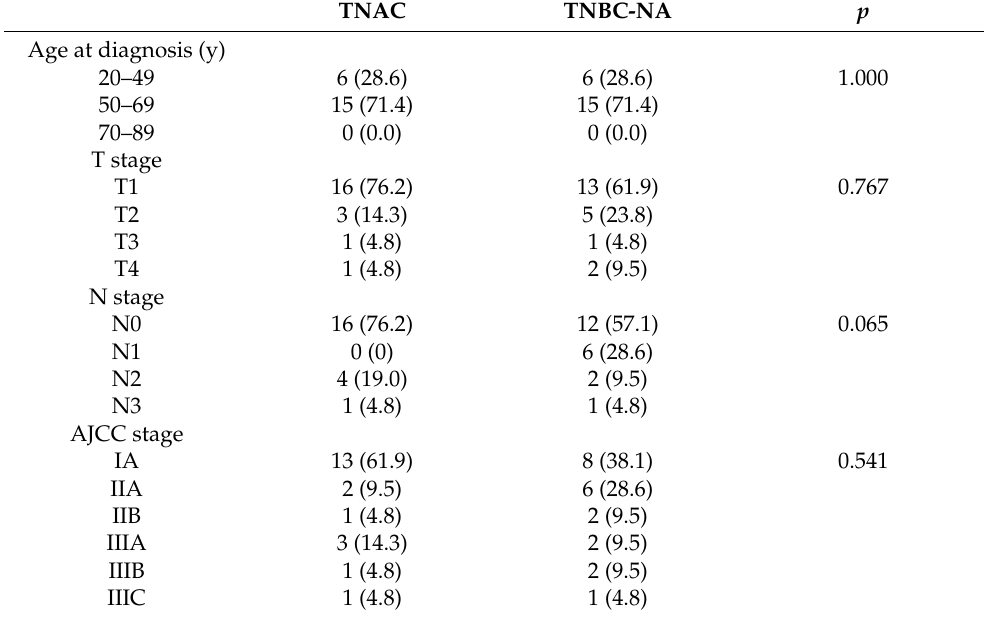
Table 2. Clinicopathological features of TNAC and TNBC-NA patients who received neoadju- vant